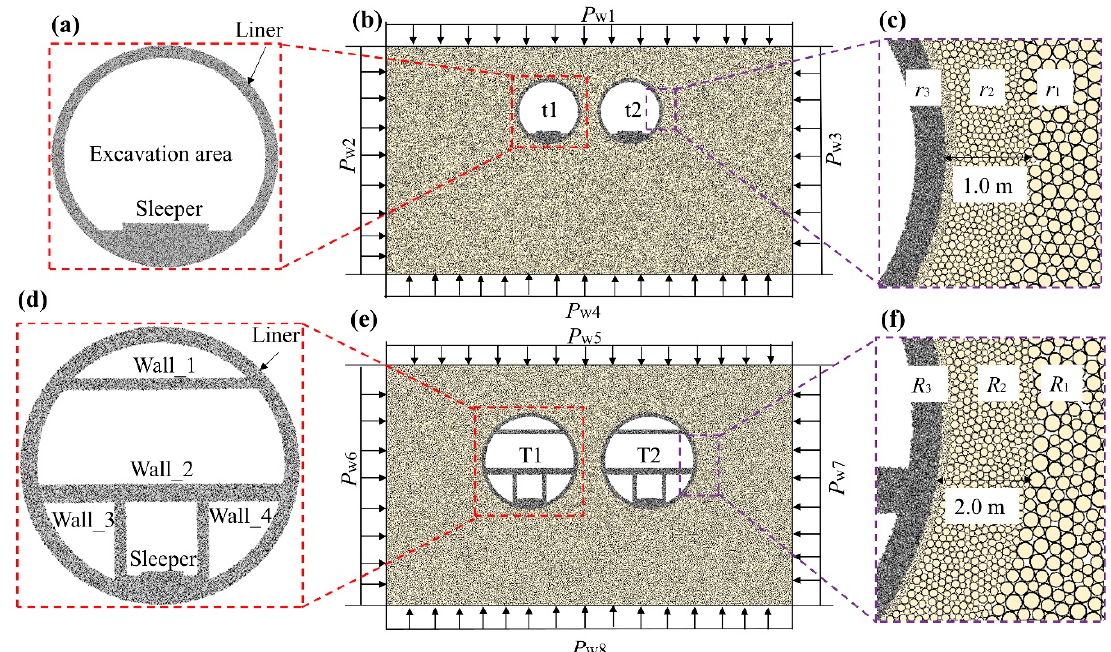
Figure 6. Small and super-large diameter twin tunnels in DEM: ( a ) Cross section of small tunnel ( d = 6.2 m); ( b ) Outline of small twin tunnels DEM model; ( c ) The size of particles in the small twin tunnels; ( d ) Cross section of super-large tunnel ( D = 15.2 m); ( e ) Outline of super-large twin tunnels DEM model; ( f ) The size of particles in the super-large twin tunnels.